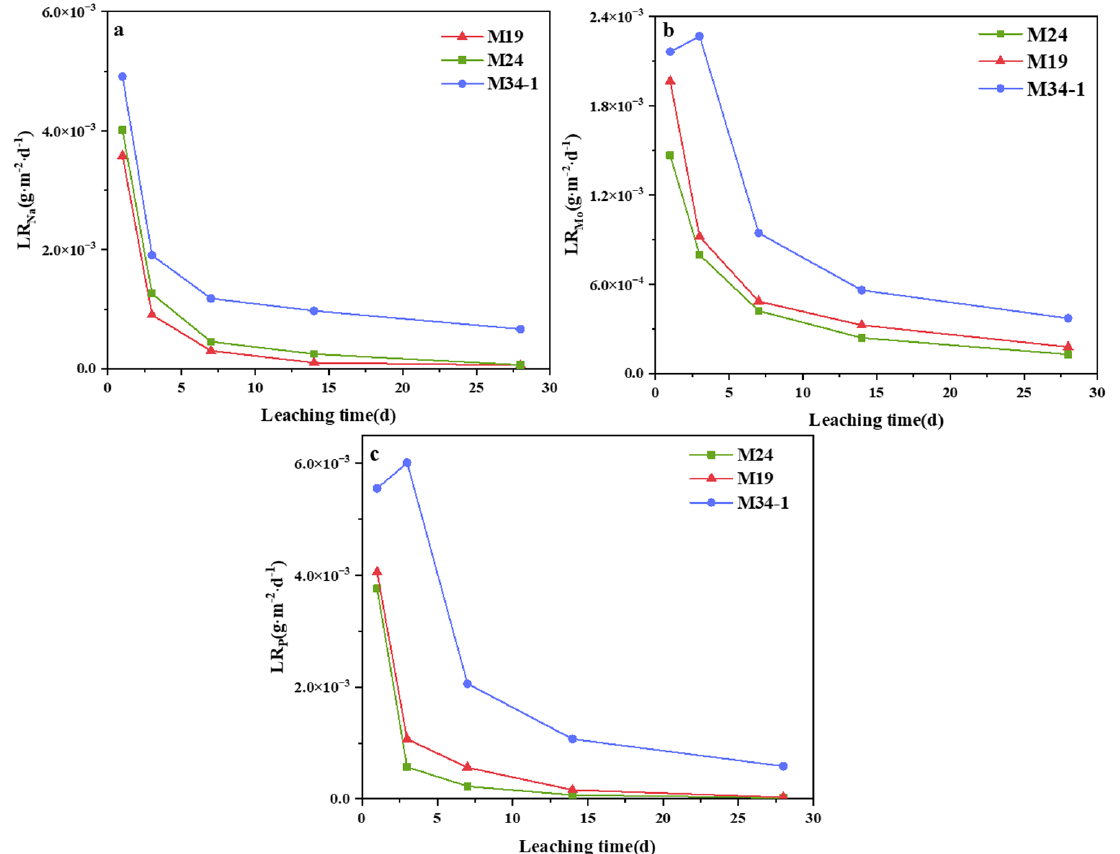
Figure 7. Normalized leaching rates of ( a ) Na, ( b ) Mo and ( c ) P.